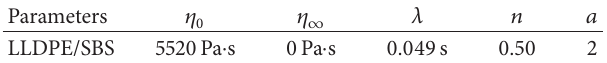
Table 2: Parameters of the lending with Carreau-Yasuda model.